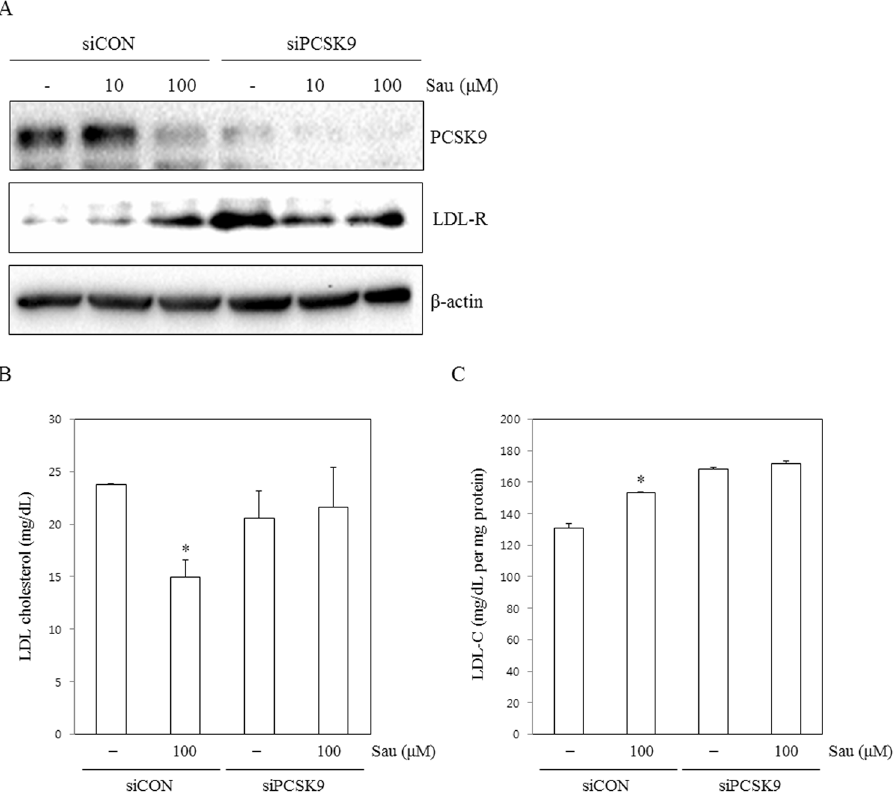
Figure 6. PCSK9 knockdown inhibits the effect of sauchinone. Identification of efficient PCSK9-siRNA sequences and measurement of the relative PCSK9 concentration 48 hours after transfection. HepG2 cells transfected with PCSK9-siRNA for 48 hours were treated with sauchinone (10 and 100 μ M) for an